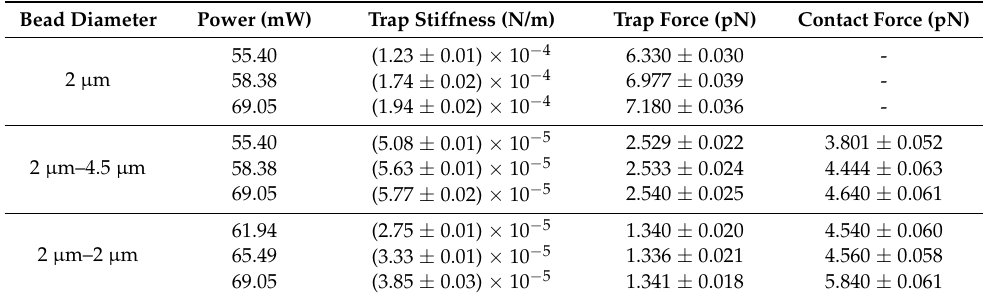
Table 2. Summary of trapping force and contact force measured in x direction for two silica beads in